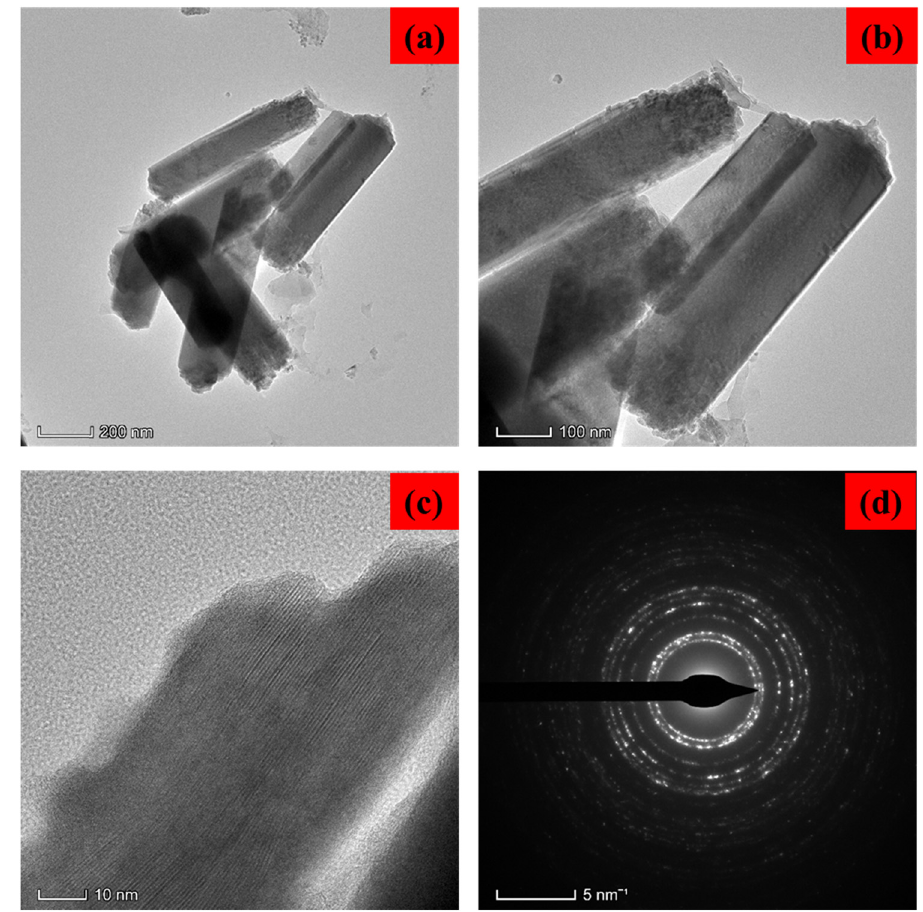
Figure 3: The TEM images of the ZnO – TiO 2 – chitosan – escin bio - nanocomposites are shown in ( a ) lower and ( b and c ) higher magni fi cations. ( d ) selected area ( electron ) di ff raction ( SAED ) patterns are shown by the bio - nanocomposites. A photomicrograph of a representative image is shown